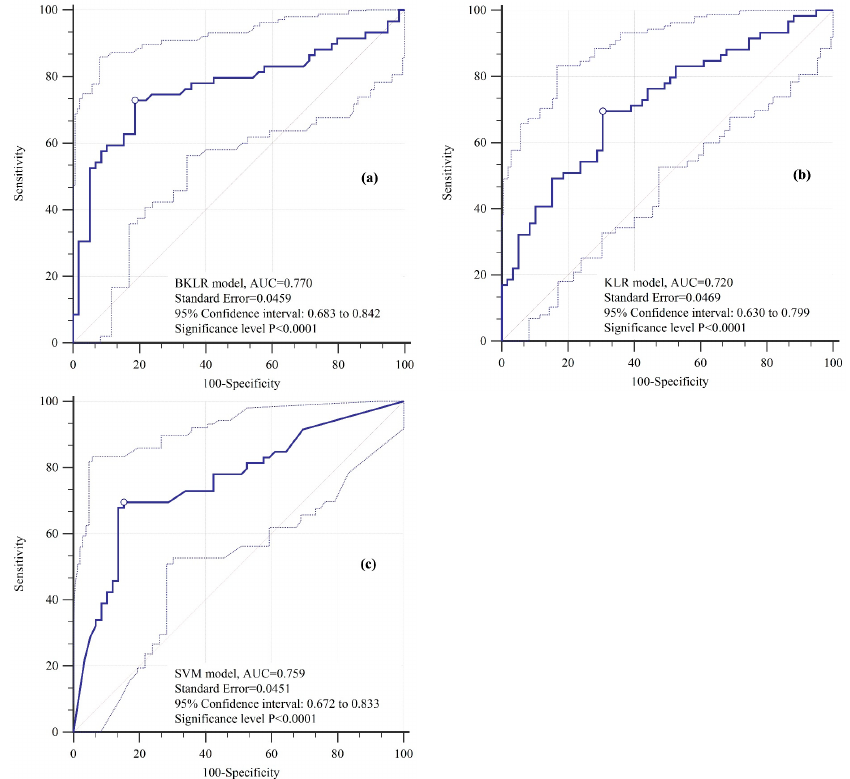
Figure 10. ROC curves using the validation dataset: ( a ) BKLR model, ( b ) KLR model, ( c ) SVM model.